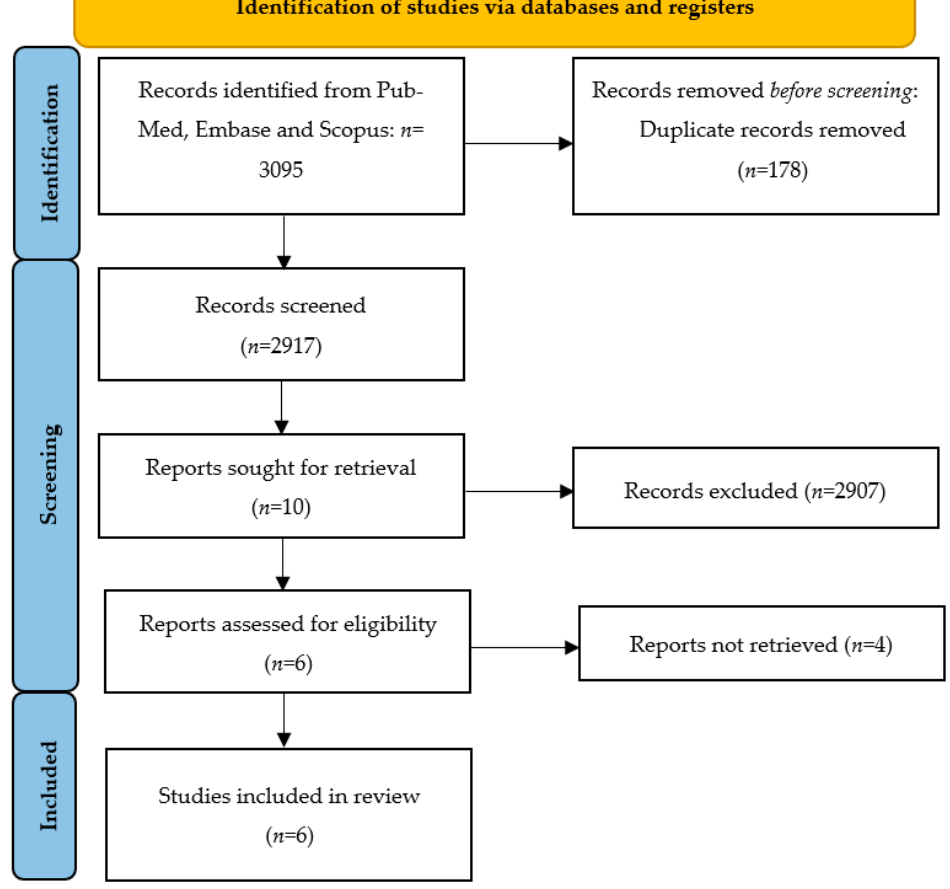
Figure 1. The Preferred Reporting Items for Systematic Reviews and Meta-Analyses (PRISMA): manuscript selection strategy and flow diagram.